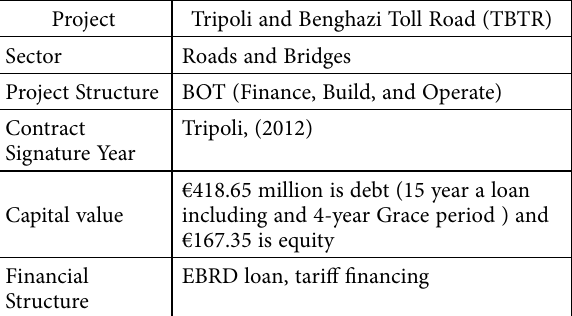
Table 3. The PPPs project case study